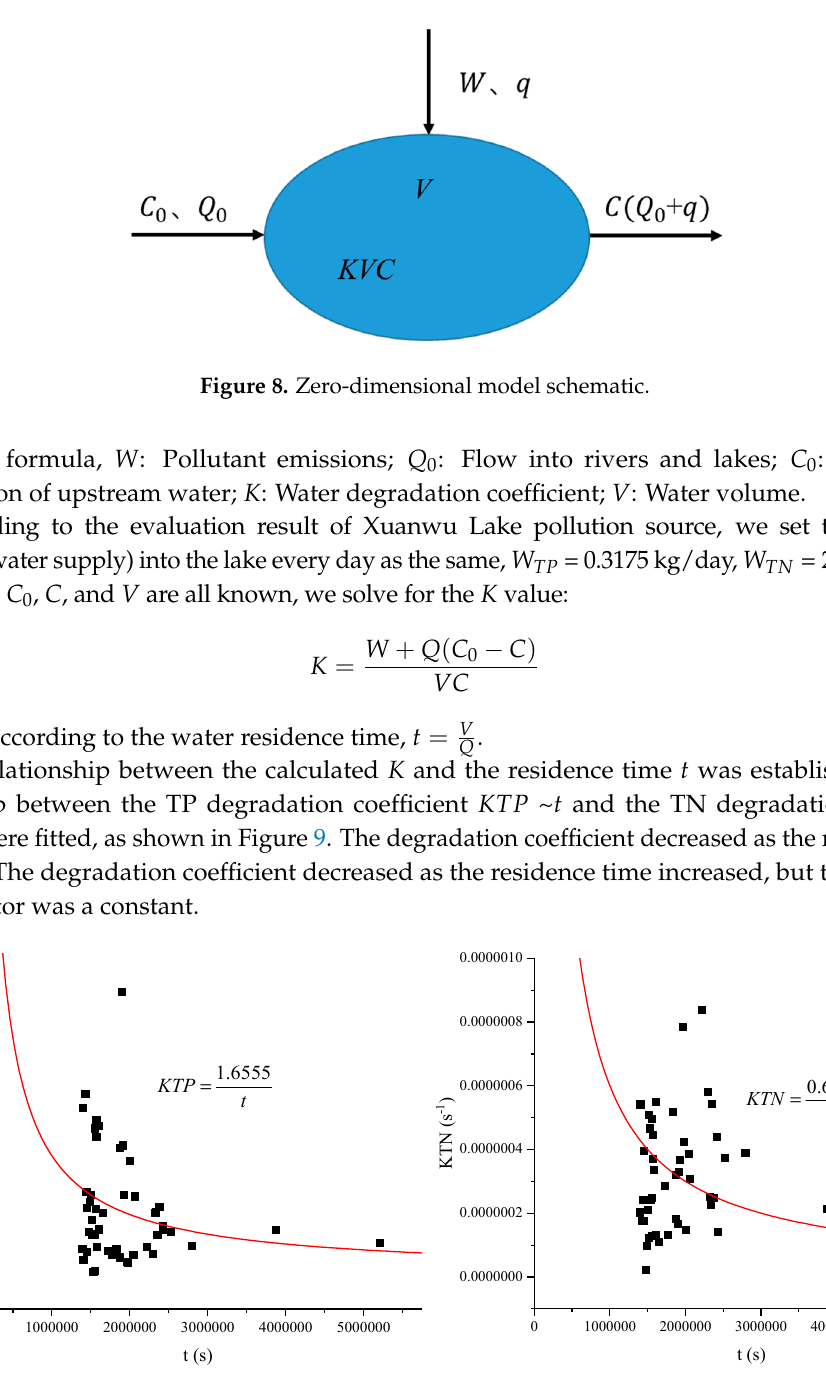
Figure 9. Relationship between water quality degradation coefficient and residence time in Xuanwu Lake. We fit each scatter plot to an inverse function. The equation is: K = B1/ t , K is the degradation coefficient, t is the residence time, and B1 is constant parameters. The B3 for each curve (left to right) is: 1.6555, 0.60077. The coefficient of determination, R-squared, for each curve (left to right) is: 0.3801, 0.2985.